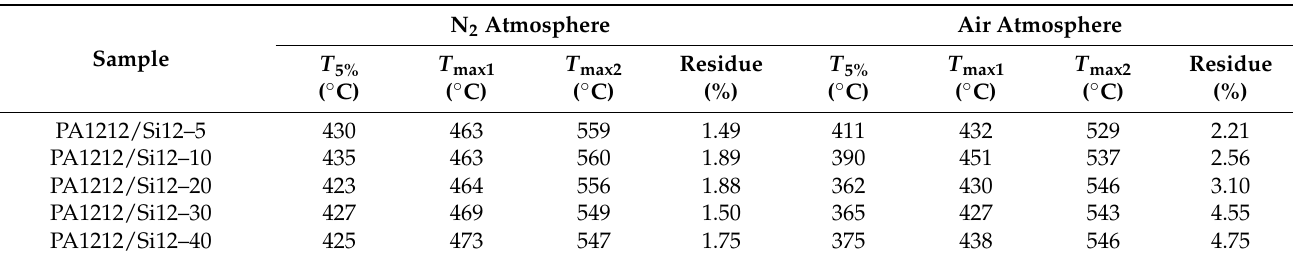
Table 3. The results of PA1212/Si12 copolymers from